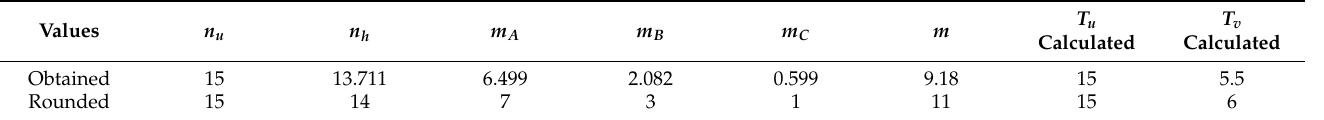
Table 4. Results of applying the formulas to the warehouse of the Glavima company with area restriction.